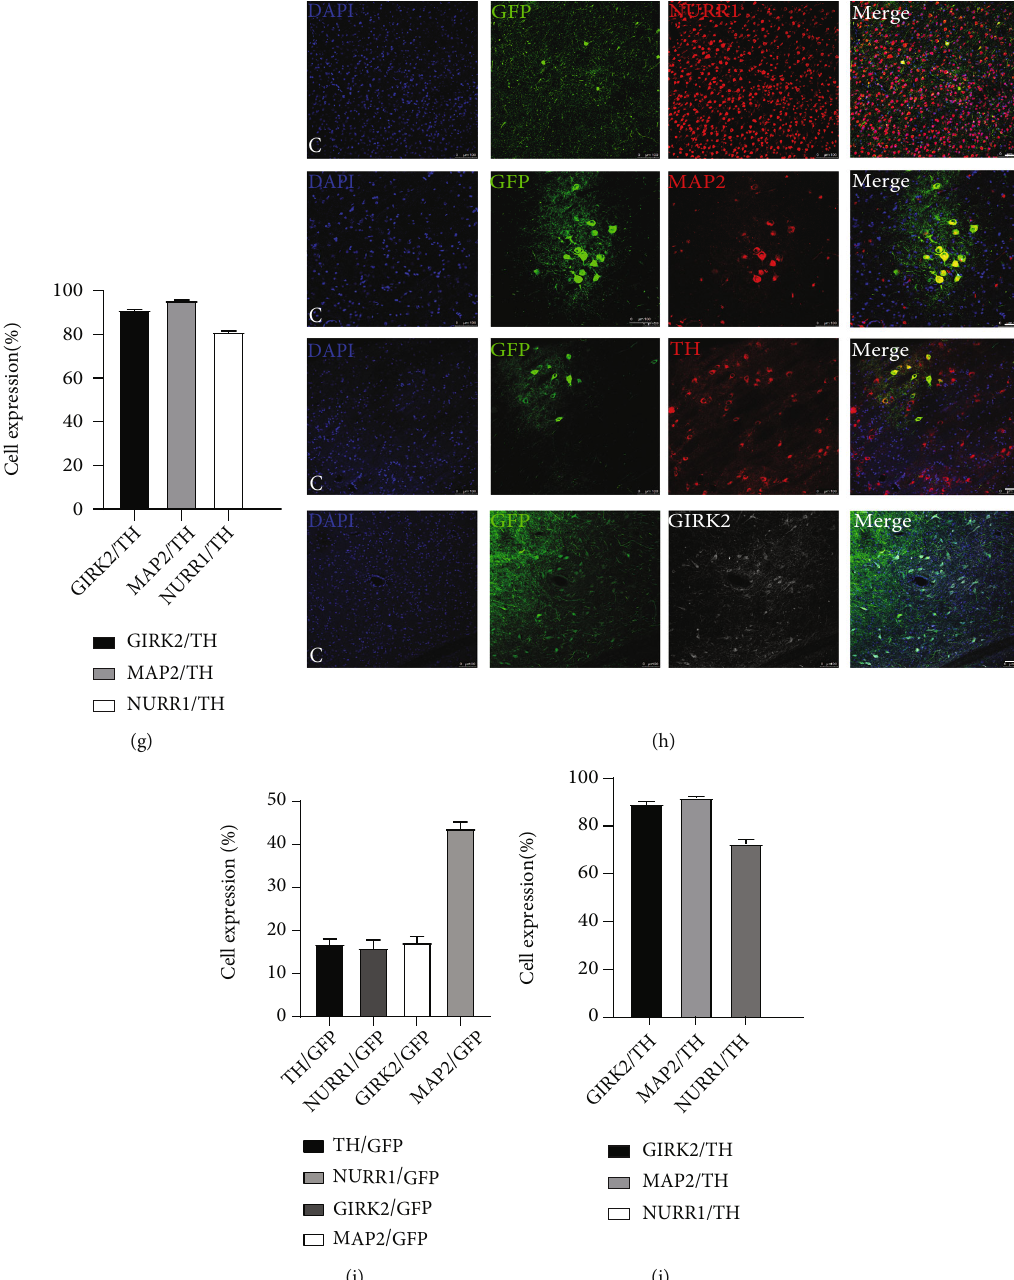
Figure 5: Characterization of cells following engraftment into di ff erent brain regions of a nonhuman primate. (a) The schematic diagram of the transplantation experiment. (b) The three brain regions selected for transplantation with region a (motor cortex) engrafted with iNSC- GFP, region b (striatum) engrafted with iNSC-DAPs, and region c (substantia nigra) engrafted with iNSC-DAPs. (c) The GFP-positive cellular grafts were detected at the three engraftment sites three months following transplantation. Scale bars, 1mm. (d) Three months following transplantation, the engrafted iNSC-GFP at the motor cortex showed the morphology of neurons. Scale bars, 250 μ m. (e) Immuno fl uorescence staining for NURR1, MAP2, TH, and GIRK2 on the transplanted iNSC-DAPs three months following engraftment into the striatum. Scale bars, 50 μ m. (f) Three months after transplantation of iNSC-DAPs, quanti fi cation of the GFP-positive cells that coexpressed TH, NURR1, GIRK2, and MAP2, respectively. (g) The proportions of TH-positive cells that coexpressed GIRK2, MAP2, and NURR1 three months following transplantation of iNSC-DAPs into the striatum. (h) Immuno fl uorescence staining for NURR1, MAP2, TH, and GIRK2 three months following engraftment of iNSC-DAPs into the substantia nigra. Scale bars, 100 μ m. (i) The proportions of surviving cells that were double-positive for GFP and TH, NURR1, GIRK2, or MAP2, respectively, at the substantia nigra. (j) The proportions of TH-positive cells that coexpressed GIRK2, MAP2, or NURR1 at the substantia